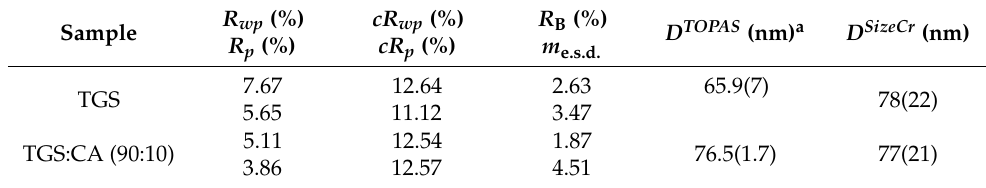
Table 3. Final agreement factors were obtained as a result of the Rietveld fitting of the calculated diffraction patterns to the experimental ones ( cR wp and cR p factors are given according to RietESD program calculations). Coefficients m e.s.d. for corrections of e.s.d.s of refined parameters obtained